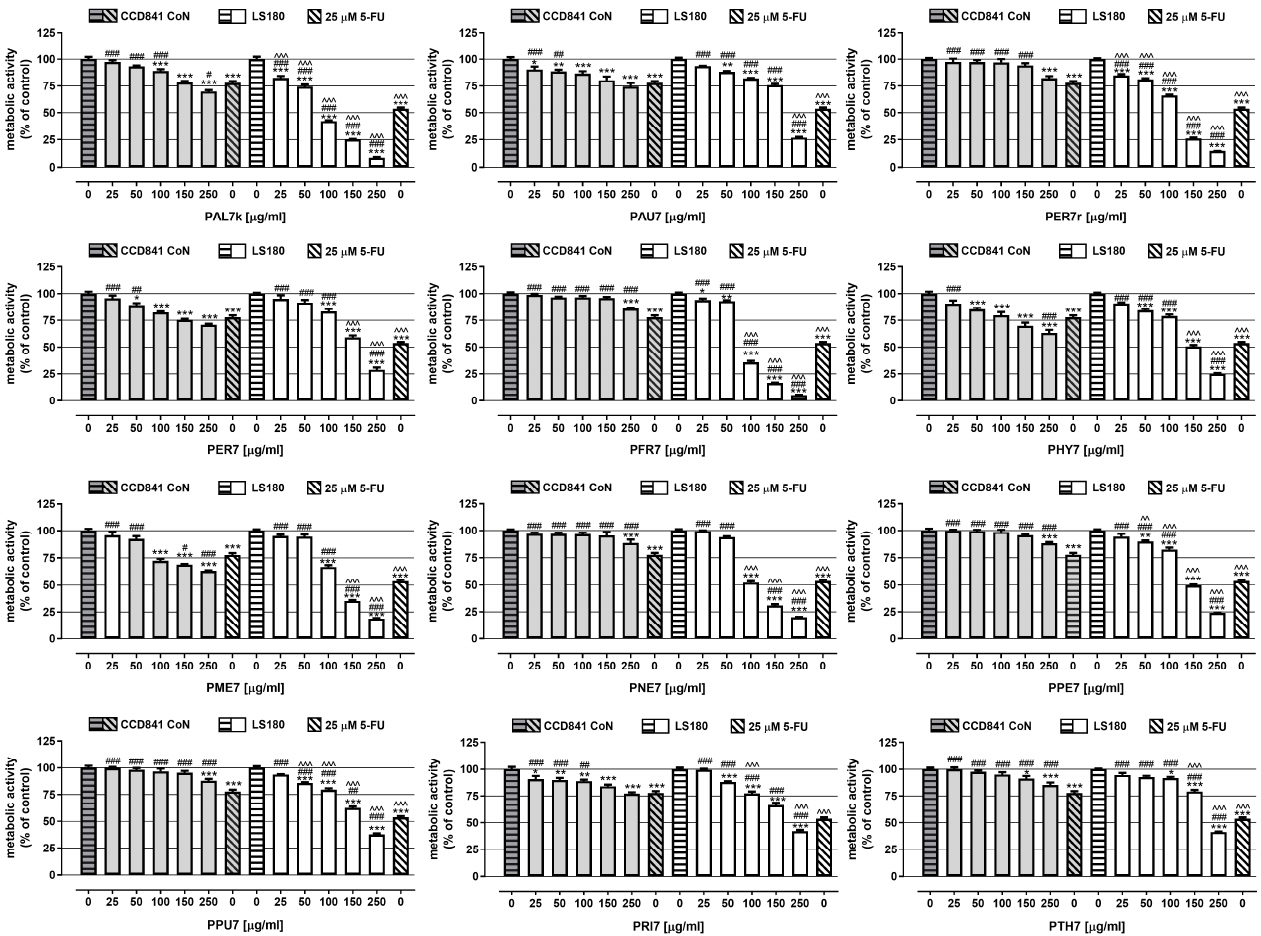
Figure 1. Influence of obtained extracts on the viability of CCD841 CoN and LS180 cell lines. The cells were exposed for 48 h to the culture medium alone (control). extract at concentrations of 25–250 µg/mL. or 25 µM 5-fluorouracil (5-FU; positive control). Metabolic activity of investigated cell lines in response to tested compounds was examined photometrically by MTT assay. Results are presented as mean ± SEM of at least 5 measurements. * p < 0.05; ** p < 0.01; *** p < 0.001 vs. control. # p < 0.05; ## p < 0.01; ### p < 0.001 vs. positive control. ^^ p < 0.01; ^^^ p < 0.001 colon cancer cells treated with extract/5-FU vs. colon epithelial cells exposed to the extract/5-FU at the corresponded concentration; one-way ANOVA test; post-test: Tukey’s.